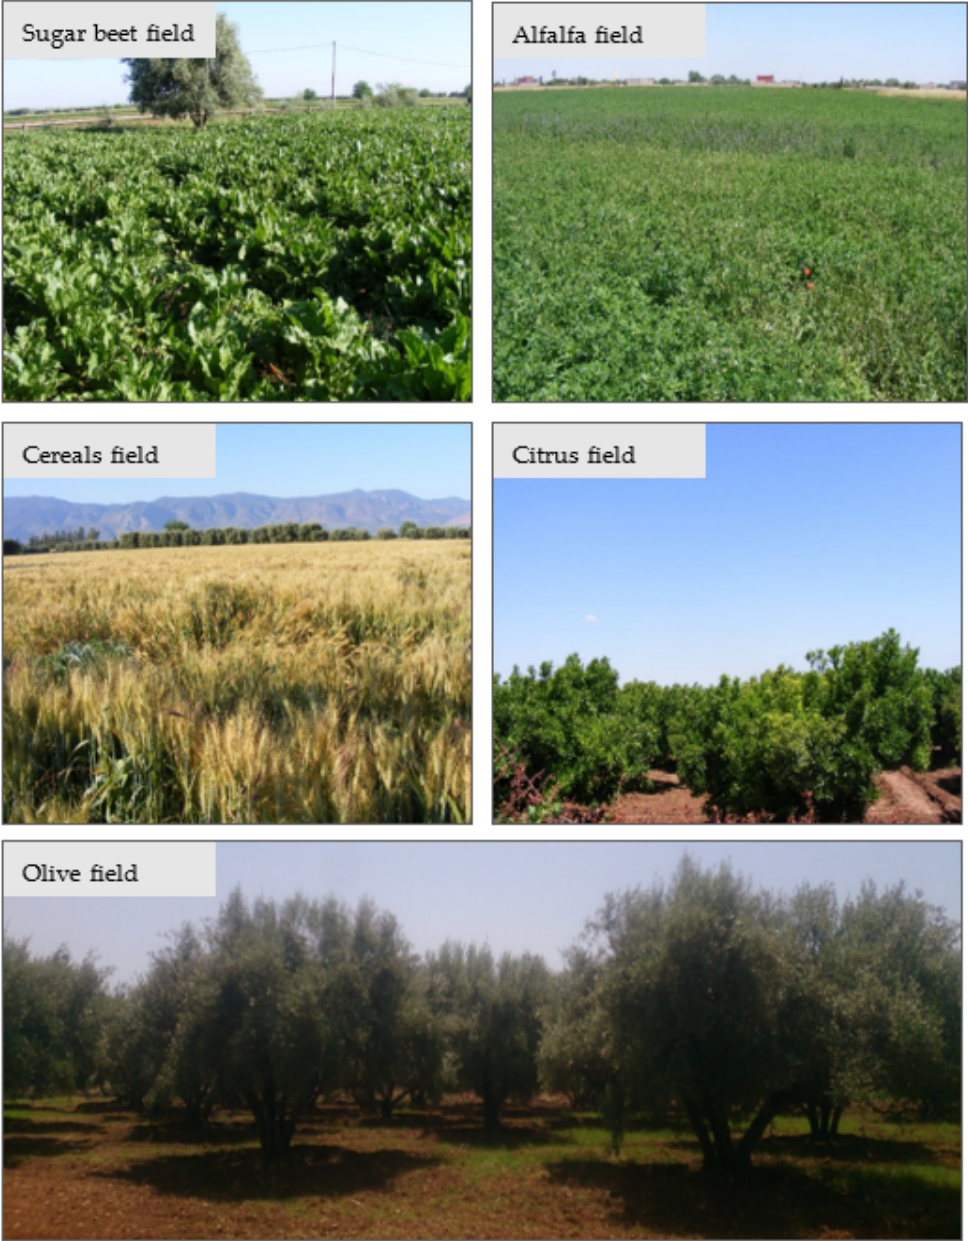
Figure 16. Pictures of some crops during the field survey.